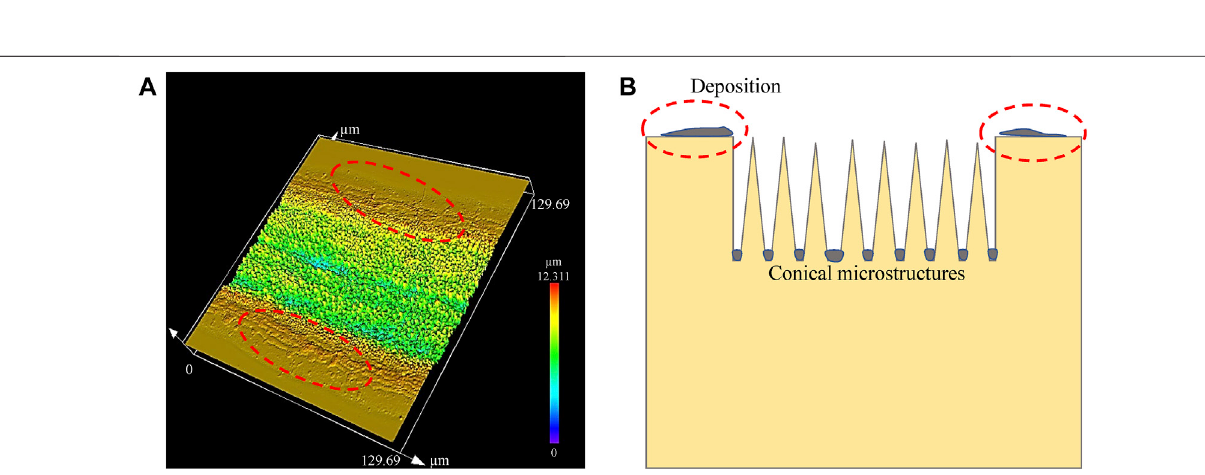
Frontiers in Physics |